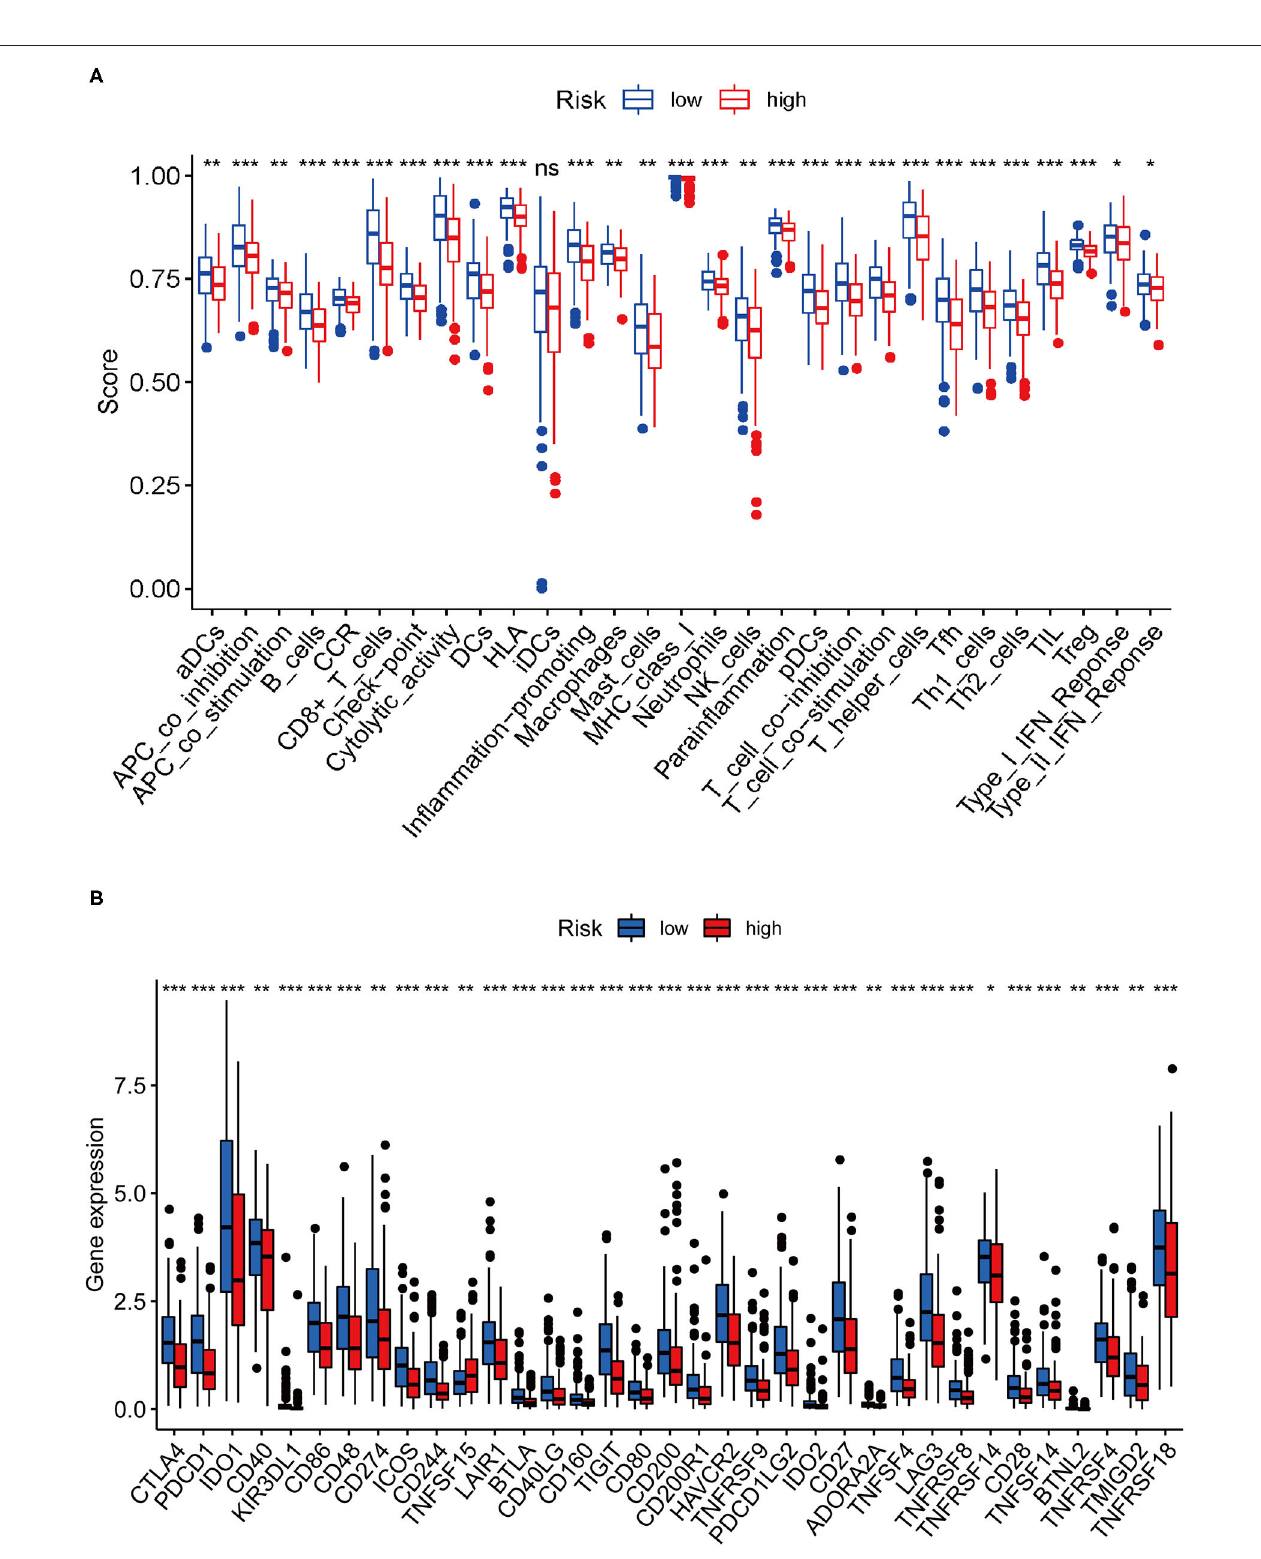
FIGURE 10 | Correlation between risk score and immune-related functions and immune checkpoint molecule expression. (A) Scores of immune cells and immune-related functions between the high- and low-risk groups. (B) Differences in the expression of immune checkpoint molecules between the high- and low-risk